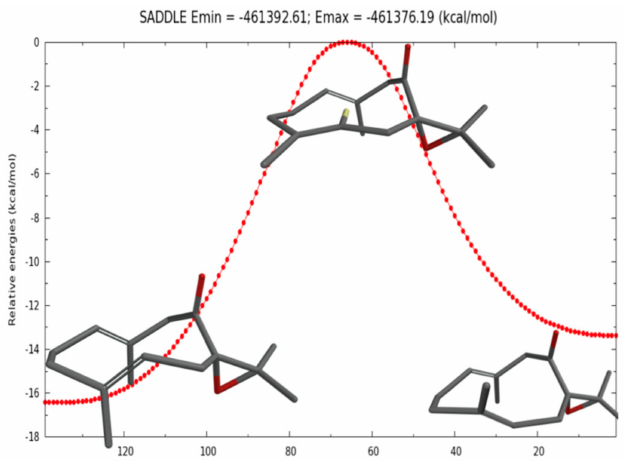
Figure 6. Barrier of exchange between conformations DD and DU and the transition state between both of them.